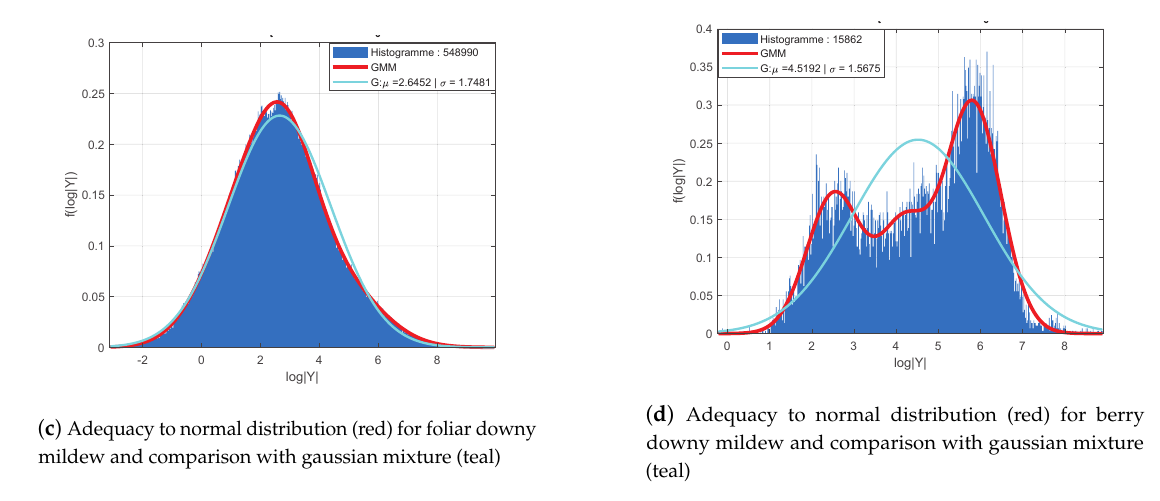
Figure 6. Adequacy of log-determinant distributions (blue) with Gaussian probability functions of same mean and variance (in red) and with Gaussian mixture models or order K=3 (in teal). Distributions are shown for healthy leaves ( a ), healthy berries ( b ), foliar downy mildew ( c ) and symptoms on berries ( d